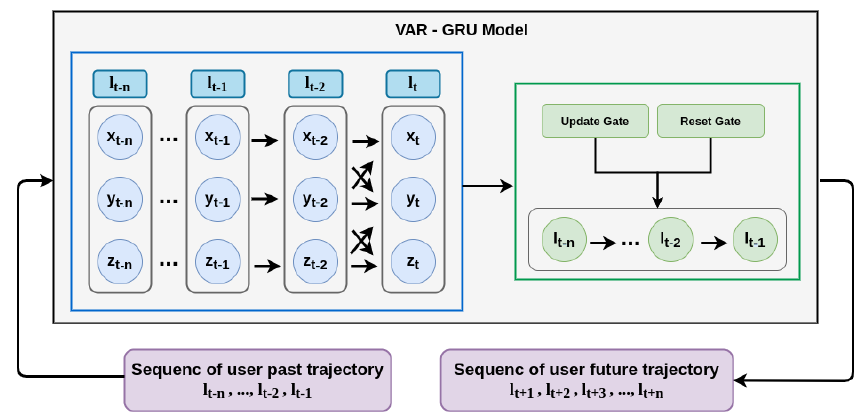
Figure 2. The proposed VAR-GRU mobility